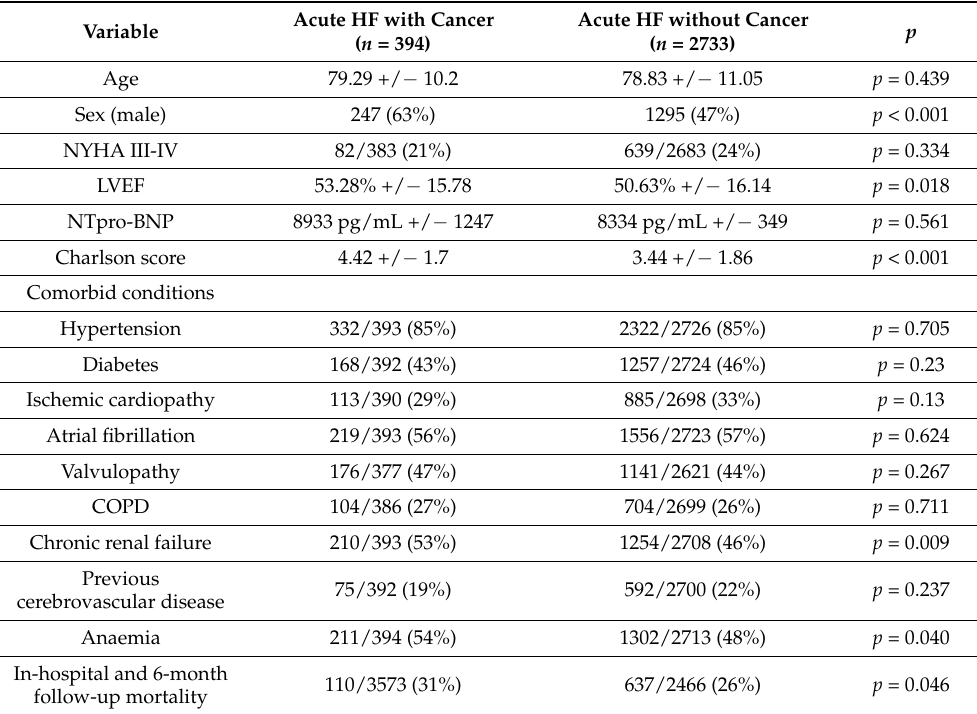
Table 1. Clinical characteristics and mortality of patients with acute heart failure with/without history of cancer.